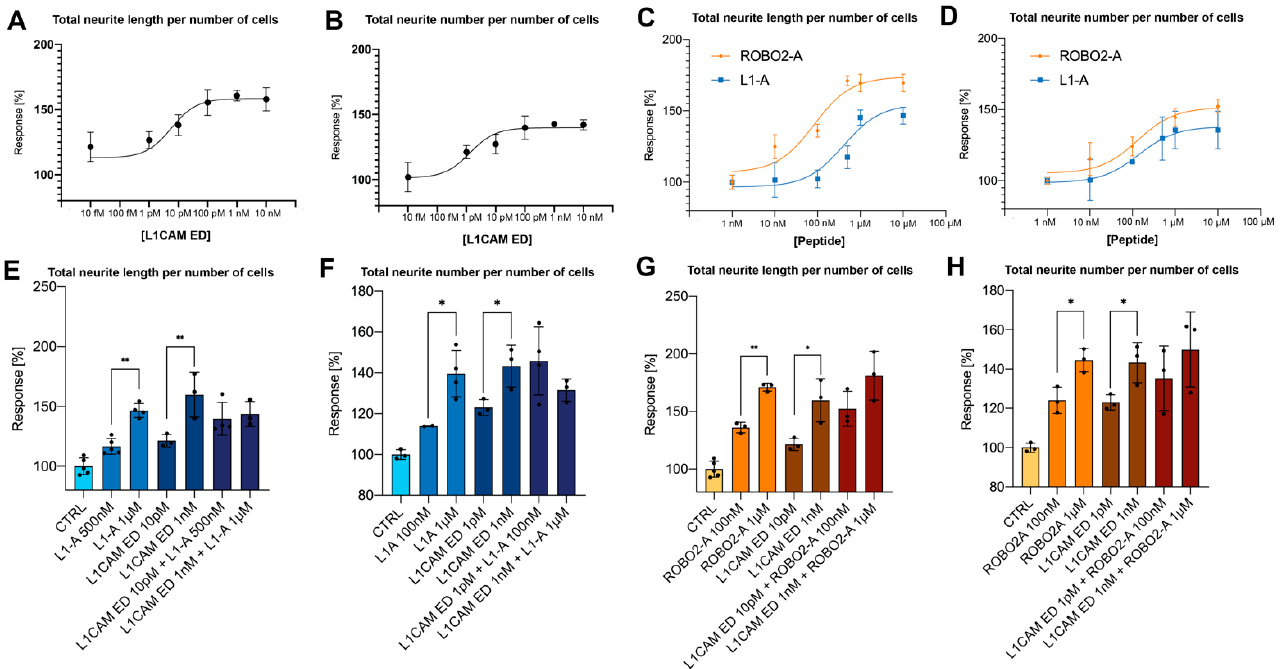
Figure 1. Effects of L1CAM ED and NOG-derived peptides on neuritogenesis. ( A ) Total neurite length per number of cells and ( B ) neurite number per number of cells of proliferating SH-SY5Y cells treated with increasing concentration of L1CAM ED (from 10 fM to 10 nM). ( C ) Total neurite length per number of cells and ( D ) neurite number per number of cells of proliferating SH-SY5Y cells treated with increasing concentration (from 1 nM to 10 µM) of either L1-A (blue) or ROBO2-A (orange). Total neurite length per number of proliferating SH-SY5Y cells treated with combination of L1-A ( E ) or ROBO2-A ( G ). Neurite number per number of proliferating SH-SY5Y cells treated with combination of L1-A ( F ) or ROBO2-A ( H ). All data represent the mean ± SD of at least three independent experiments. Significance at p < 0.05 (*), p < 0.001 (**), between treated samples and untreated control is reported.